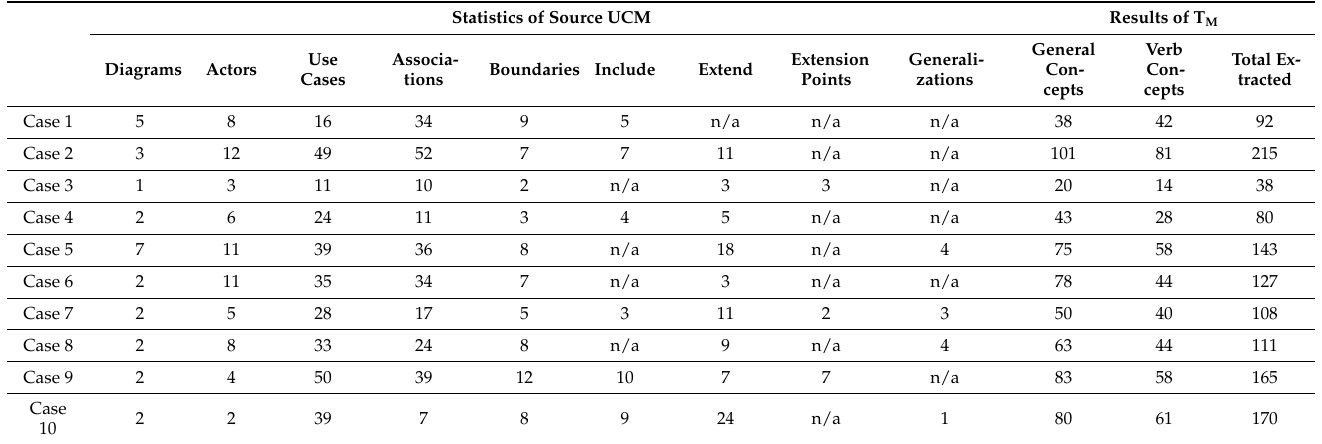
Table 1. Statistics of the input set S and benchmark results of T M . Statistics of Source UCM Results of T